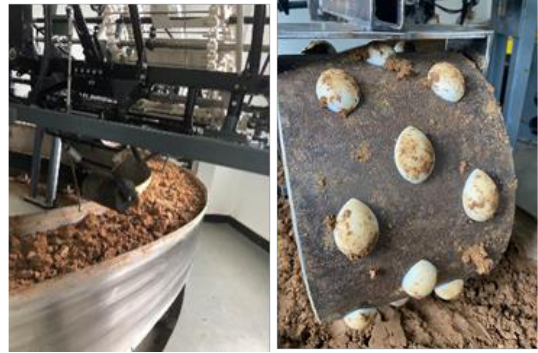
Figure 8. Soil dynamic process of the press roller.